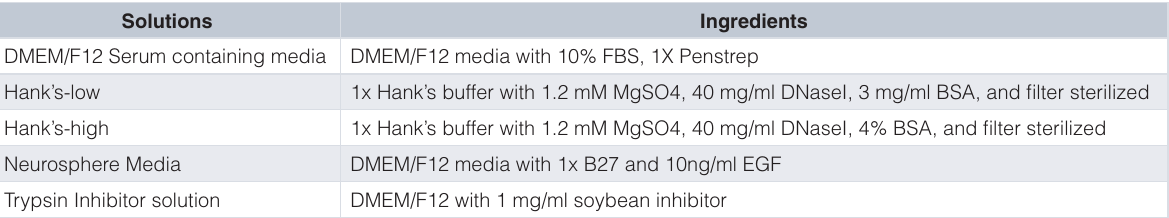
Table 2. Premade solutions for neurosphere assay.